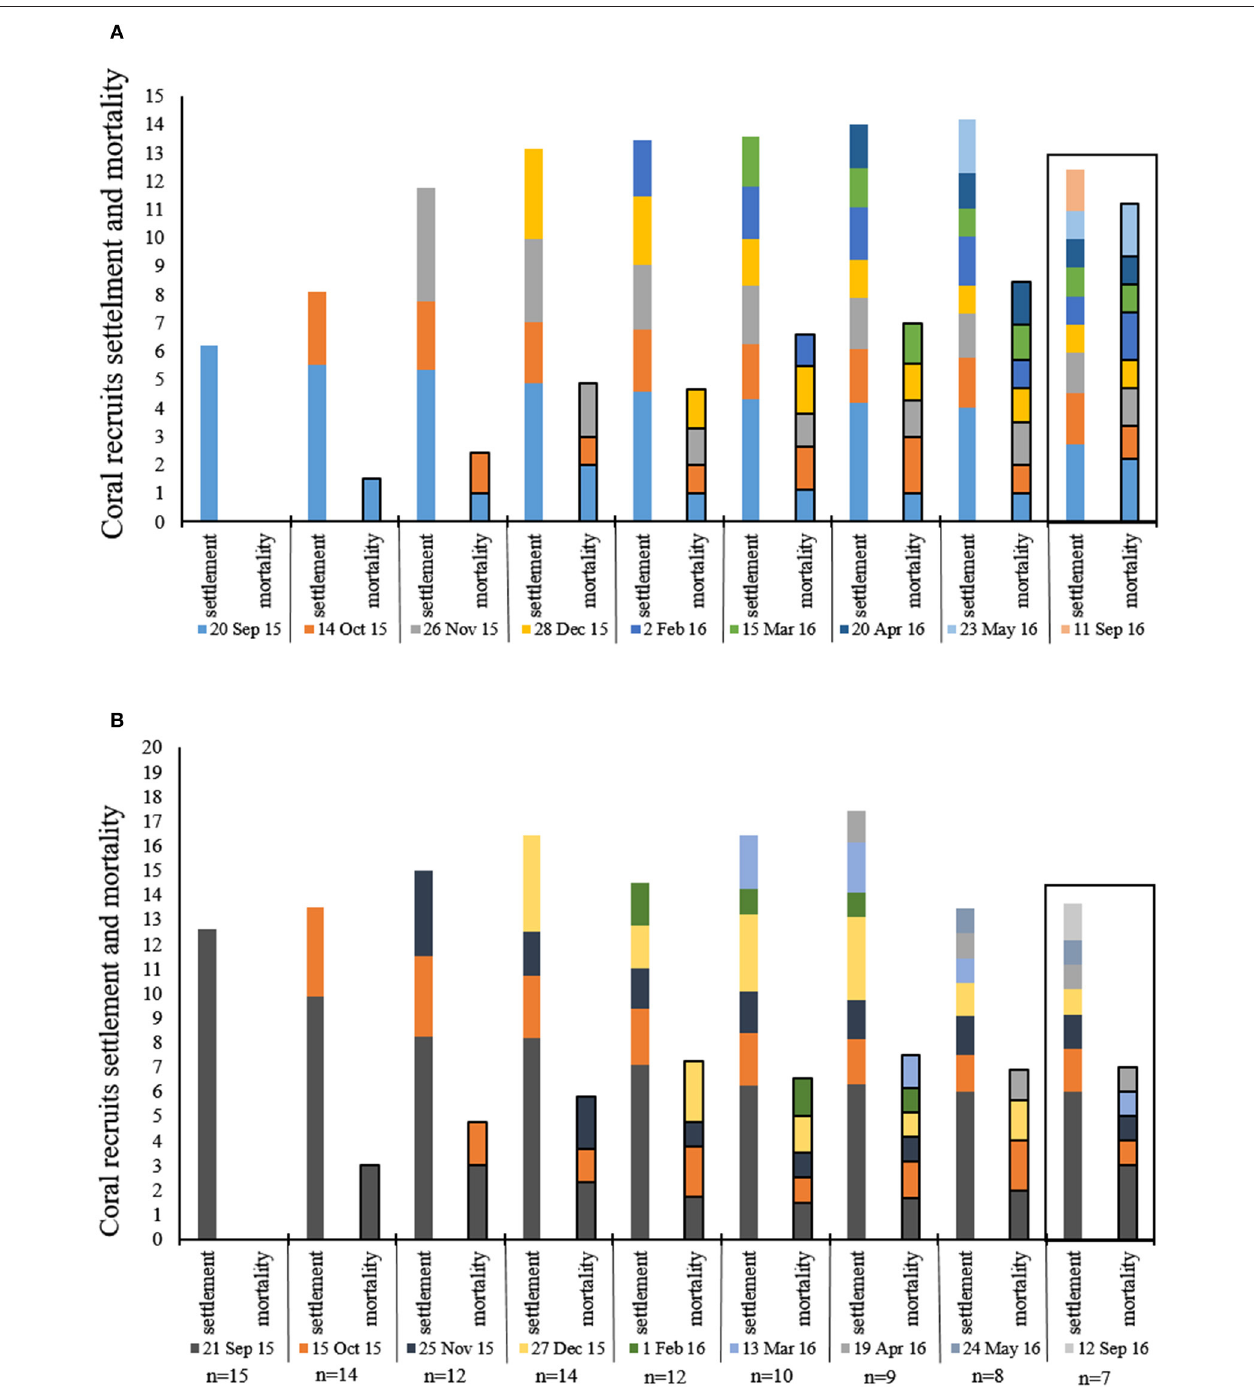
FIGURE 6 | Mean number (20 × 20cm quadrat) of coral recruits settlement and mortality during each month of the survey. Each color represents 1 month in which new recruites were recorded, the same color follows the same recruits signifies their survival and mortlity from month to month. (A) reserve ( n = 18), (B) IUI. Box around September 2016 emphasizes the 4 month gap from last survey and the return to the survey sites after 1 year.